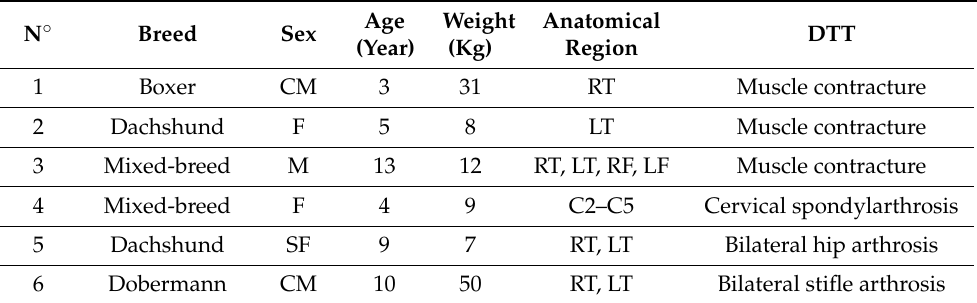
Table 1. Signalment of dogs underwent to thermographic investigation, anatomical regions treated by Tecar theraphy, disease treated by Tecar therapy (DTT). CM = Castrated Male, F = Female, M = Male, SF = Spayed Female. RT = right thigh; LT = left thigh: RF = right forelimb; LF = left forelimb. Age N ◦ Breed Sex (Year)